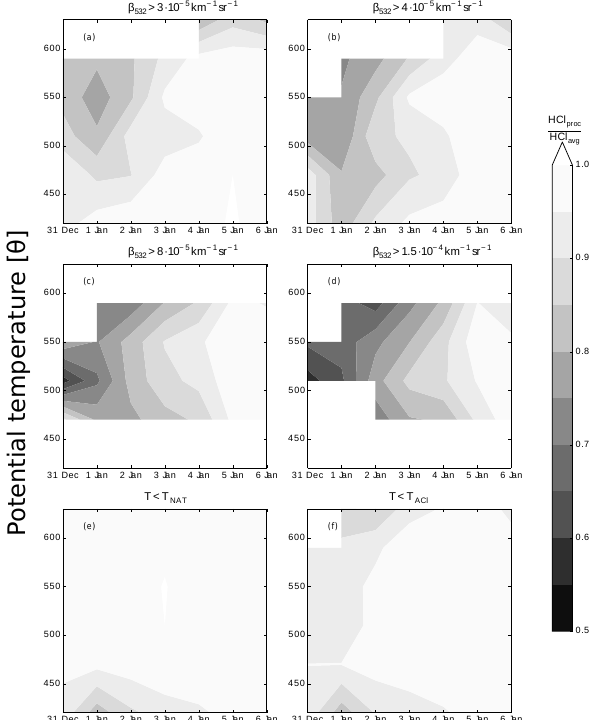
Figure 4. Ratio of average HCl mixing ratio of air that passed through a specified area to the vortex average HCl mixing ratio. The ratio is calculated for six areas, four encompassed by backscat- ter thresholds (a–d) and two by temperature thresholds ( T NAT , e and T ACl , f ). A ratio of less than one indicates air inside the contour has a lower HCl mixing ratio than the vortex average.